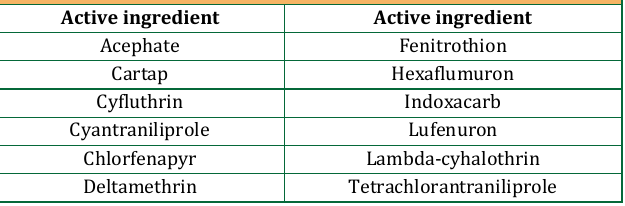
Table 4: Chemical insecticides used against the fall armyworm by Jing et al.,